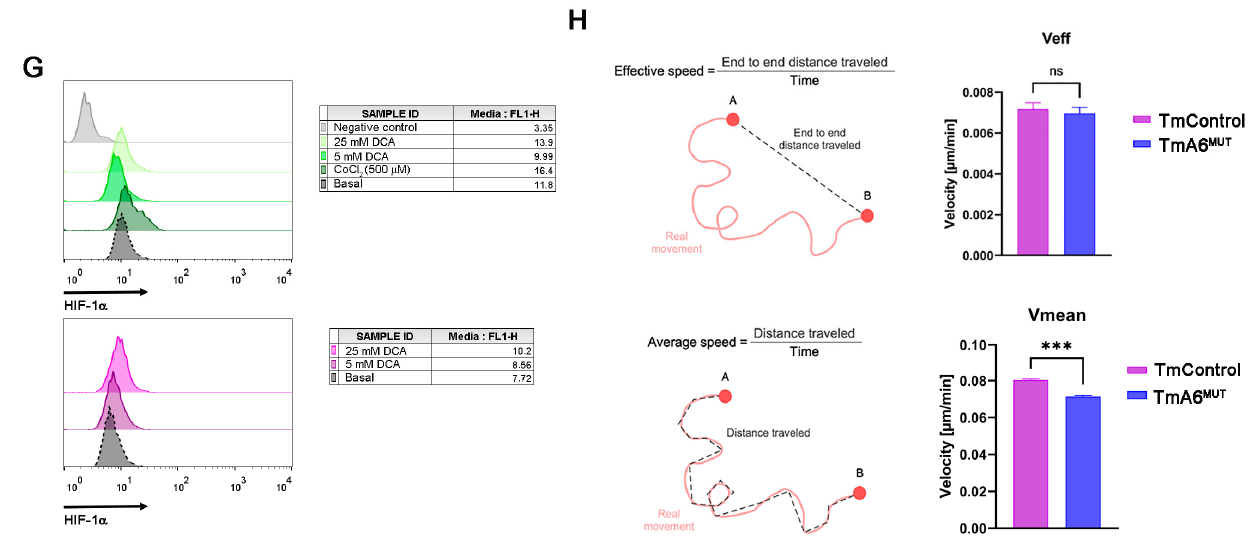
Figure 6. Tumor phenotype analysis: ( A ) MT-ATP6 mutations found in human cancers are highlighted in green and the corresponding amino acid change is indicated under the human sequence [33]. Red dots indicate that the mutation promotes a change that is identical to the murine sequence. Blue dot indicates two different changes in the same position; ( B ) MHC-I expression analysis in untreated TmControl and TmA6 MUT cells determined by flow cytometry; ( C ) Cell growth (left) and cell death (right) after treatment with different DCA concentrations. Cell growth effect was measured using the MTT reduction method ( n = 2 for each cell line and treatment; p = 0.0109 and 0.0108 for 5 mM and 25 mM DCA, respectively). To evaluate cell death, cells were simultaneously stained with annexin-V-FITC and 7 AAD and fluorescence was measured by flow cytometry ( n = 3 for each cell line and treatment); ( D , E ) effect of different DCA concentrations on MHC-I expression ( D ) and on mitochondrial superoxide production ( E ) in TmControl (upper panels) and TmA6 MUT (lower panels) cell lines by flow cytometry; ( F , G ) analysis of HIF-1 α expression levels in basal conditions; ( F ) and after treatment with different concentrations of DCA; ( G ) by immunocytochemistry followed by flow cytometry. CoCl 2 (500 µ M) was included as a control of hypoxia induction effect; and ( H ) Evaluation of cell migration using microfluidic devices. Definition (left panels) and measurement (right panels) of effective (Veff) and mean (Vmean) speed for TmControl and TmA6 MUT cells ( n = 3 independent experiments with 3 technical replicas each; p < 0.001). Asterisks indicate statistically significant differences between control and mutant cells: * indicates p < 0.05 and *** indicates p < 0.001.